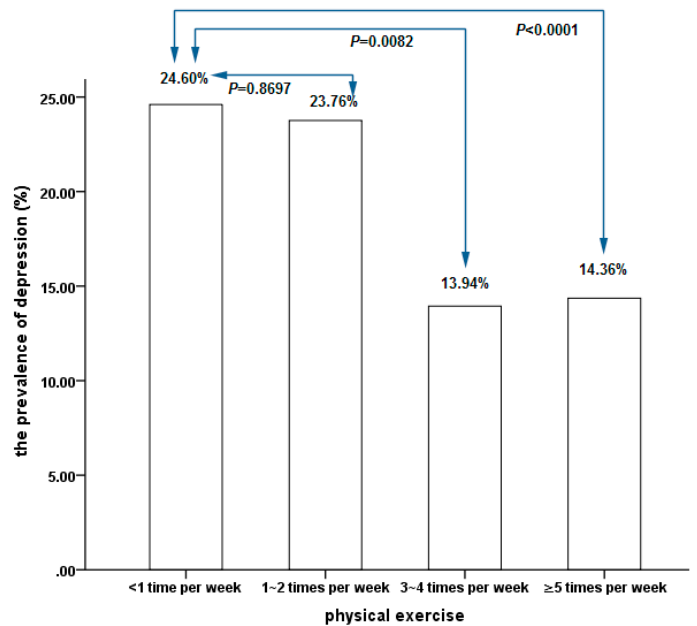
Figure 1. Comparison of the prevalence of depression that was associated with four different frequencies of physical exercise.